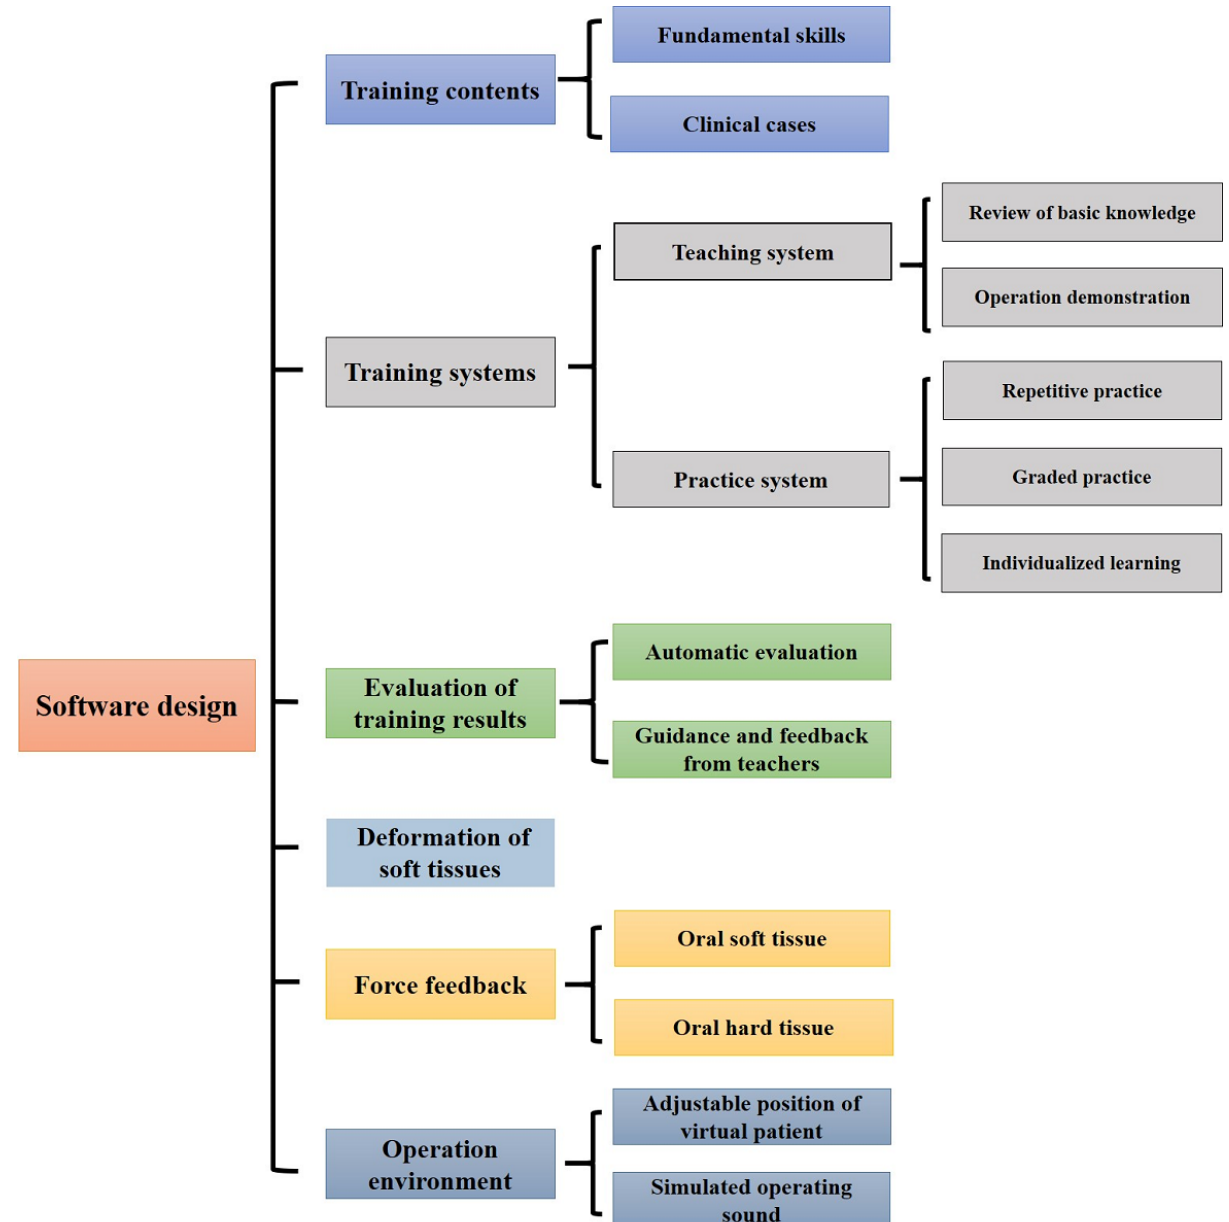
Figure 5. Software design required for an ideal dental